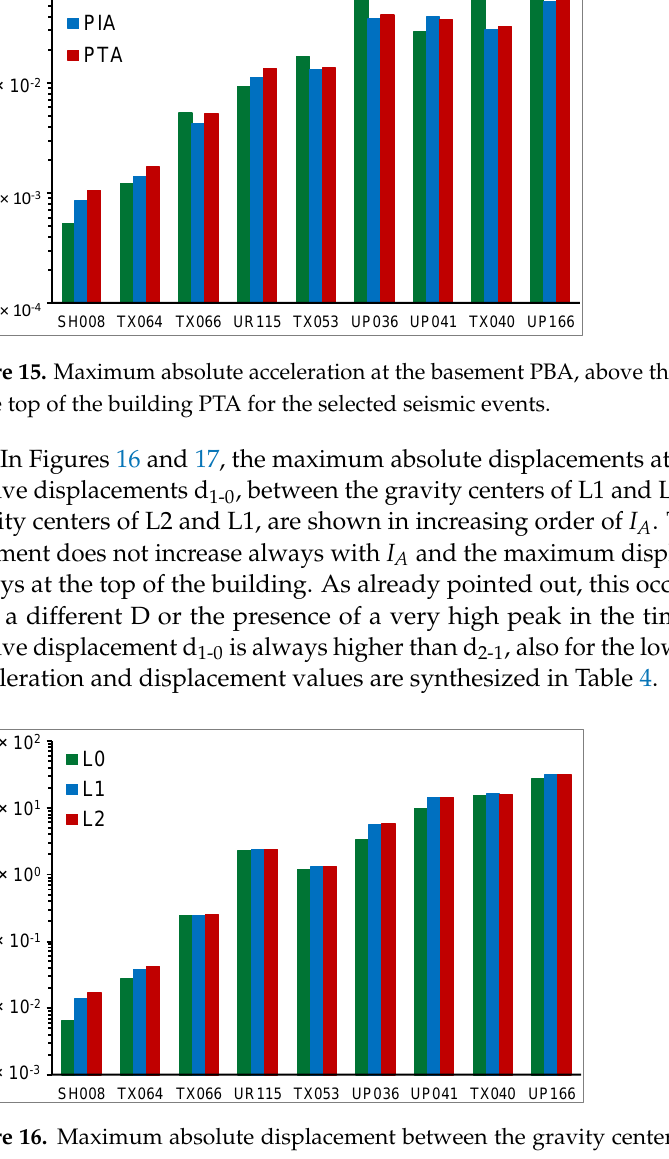
Figure 17. Maximum relative displacement between the gravity centers at L1 and L0, and at L2 and L1, for the considered seismic events. Figure 18. First resonance frequencies versus I A for all the recorded seismic events. 4. Non-Linear Modelling of the Isolation System The design frequency of the structure is 0.39 Hz, while during the seismic events in which the isolation system was activated, the resonance frequency varies between 0.8 Hz and 2.5 Hz. This effect is to be related to the change of the stiffness of the isolation devices, which depends on the angular strain. A suitable model to represents this behavior was set up with reference to another building, seismically isolated with HDRBs produced by the same manufacturer, which is also part of the Civil Protection Centre at Foligno [27]. The devices used for the type tests at time of construction, and properly conserved, were subjected to the displacement time history obtained in the devices on site during the 30 October 2016 Norcia earthquake. In